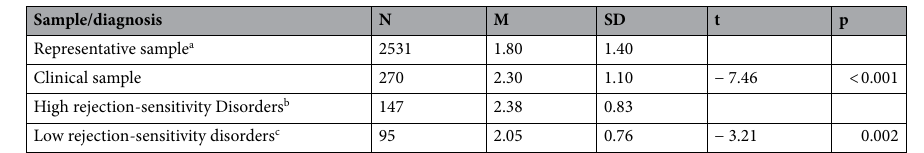
Table 3. Comparison of SPQ values between representative and clinical sample and between patient subsamples with high or low rejection sensitivity. a SPQ for the representative sample is not normally distributed. Median and interquartile range are given, and Yuan-Bentler test is reported. b Personality disorders, depression, social anxiety disorder. c Other anxiety disorders, trauma-related